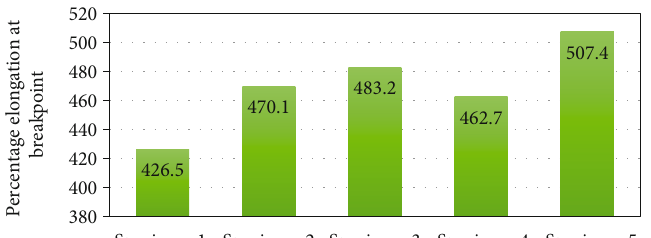
Figure 6: Comparison of the percentage elongation % for the printed specimen.